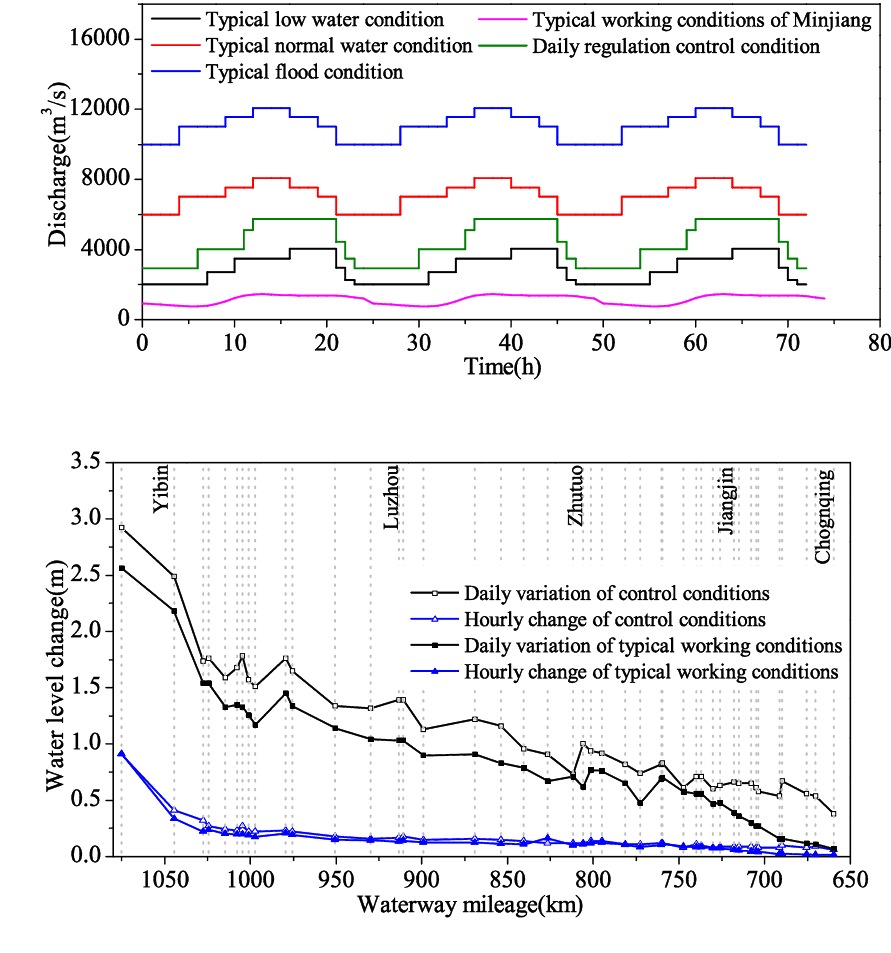
Fig. 14 Typical daily adjusted unsteady flow conditions